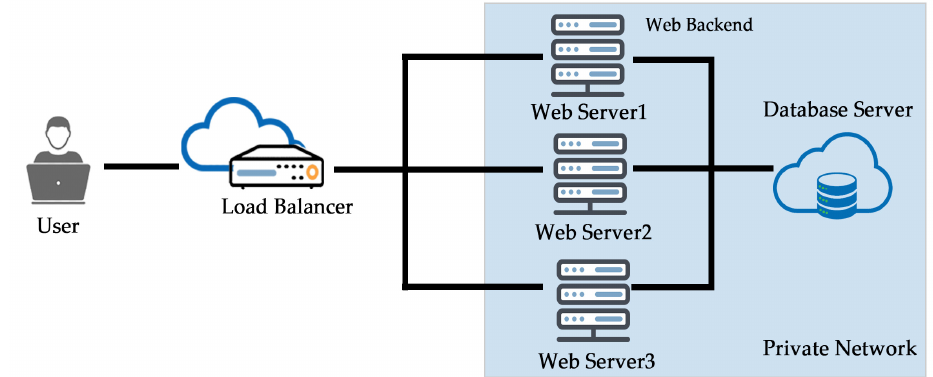
Figure 11. Cloud architecture implementation on DigitalOcean. Sensors 2020 , 20 , x FOR PEER REVIEW